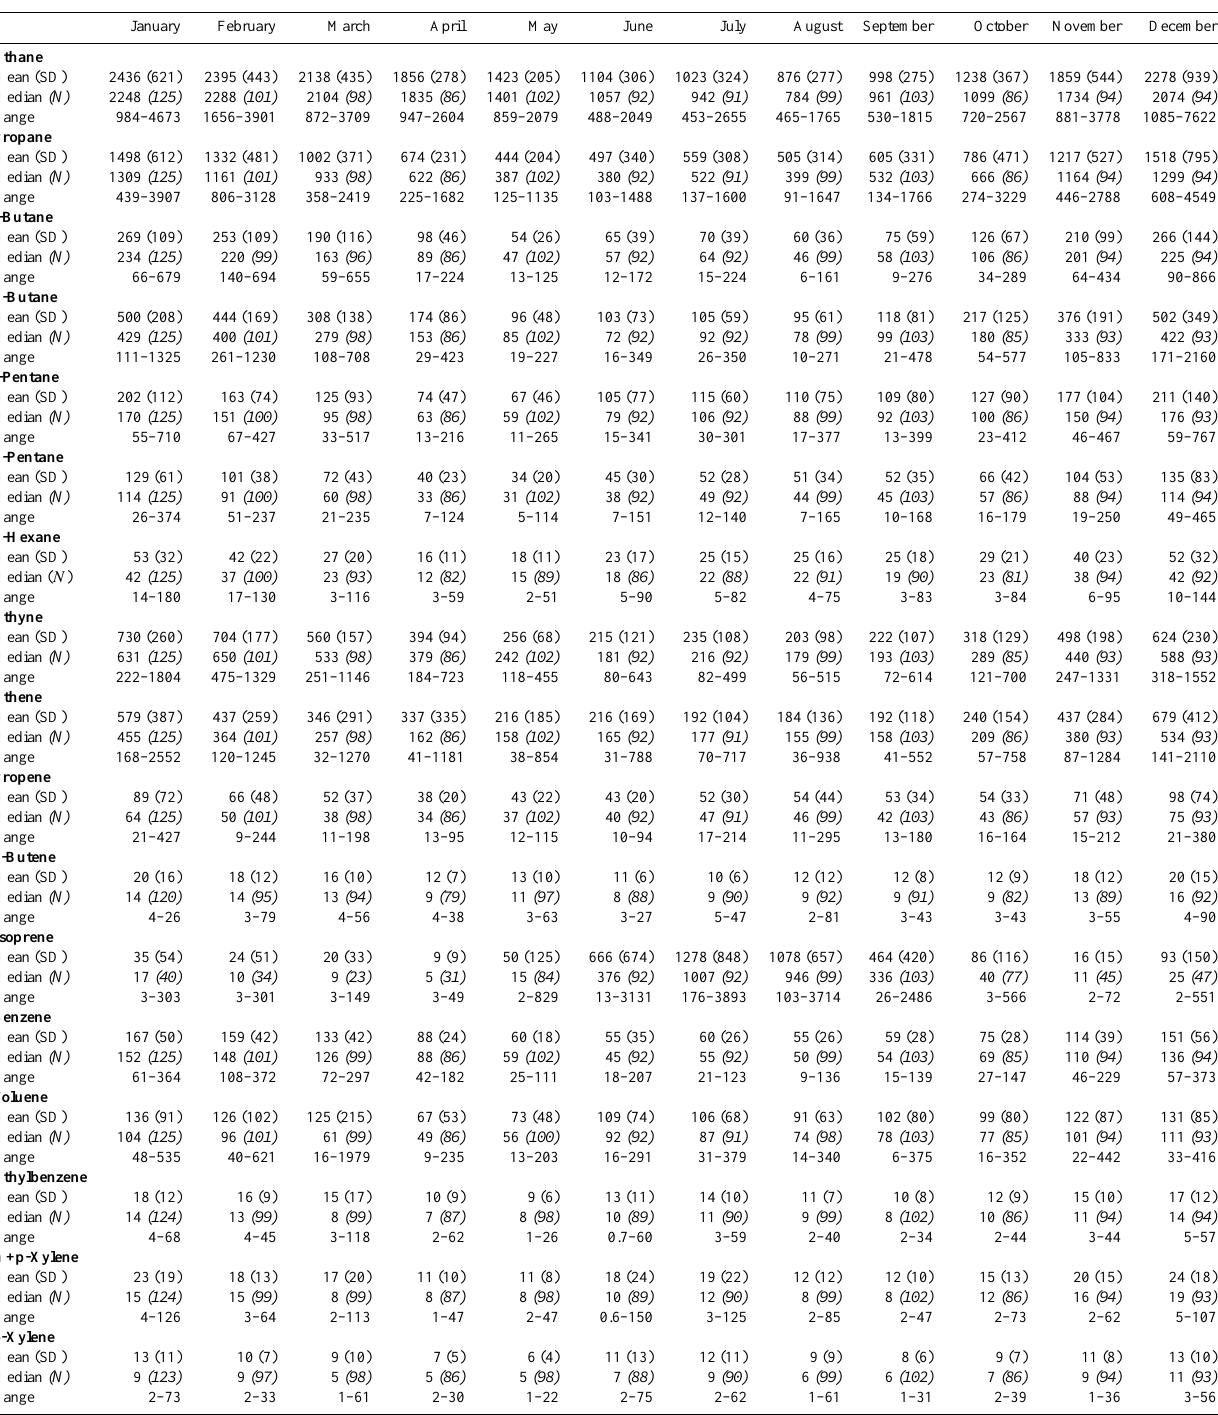
Table 1. Monthly NMHC statistics (pptv) for January 2004–February 2008. SD is the standard deviation. N is the number of